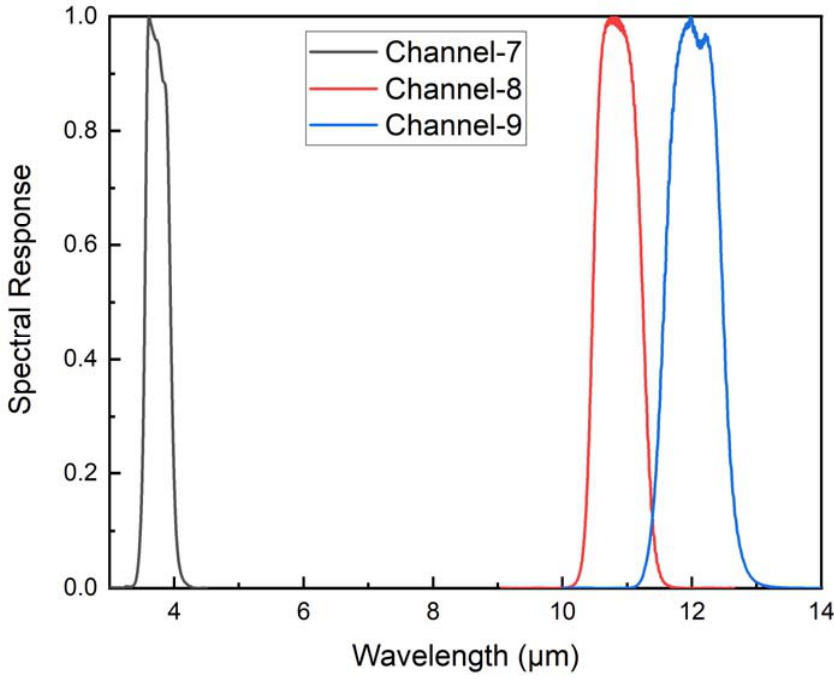
Figure 2. The spectral response functions of the MIR and TIR channels of the SLSTR data.